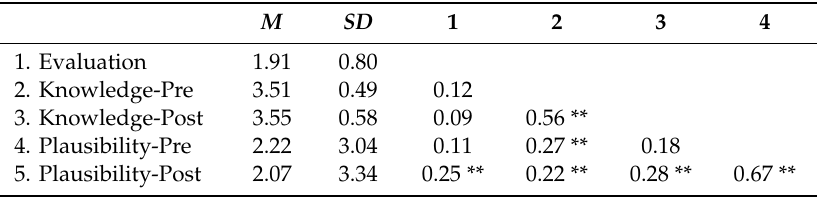
Table 1. Descriptive Statistics and Correlations between the Wetlands pcMEL structural equation modeling (SEM) latent variables.